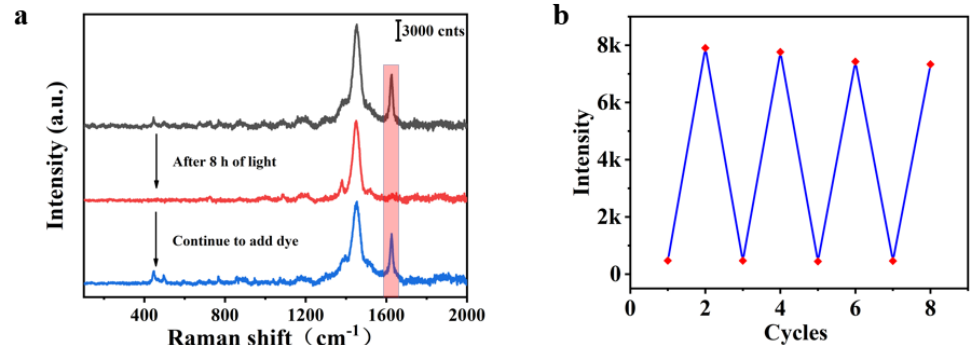
Figure 12. ( a ) SERS spectra of the composite film under one illumination cycle, ( b ) the Raman intensity of the characteristic peak of the composite substrate under four illumination cycles.